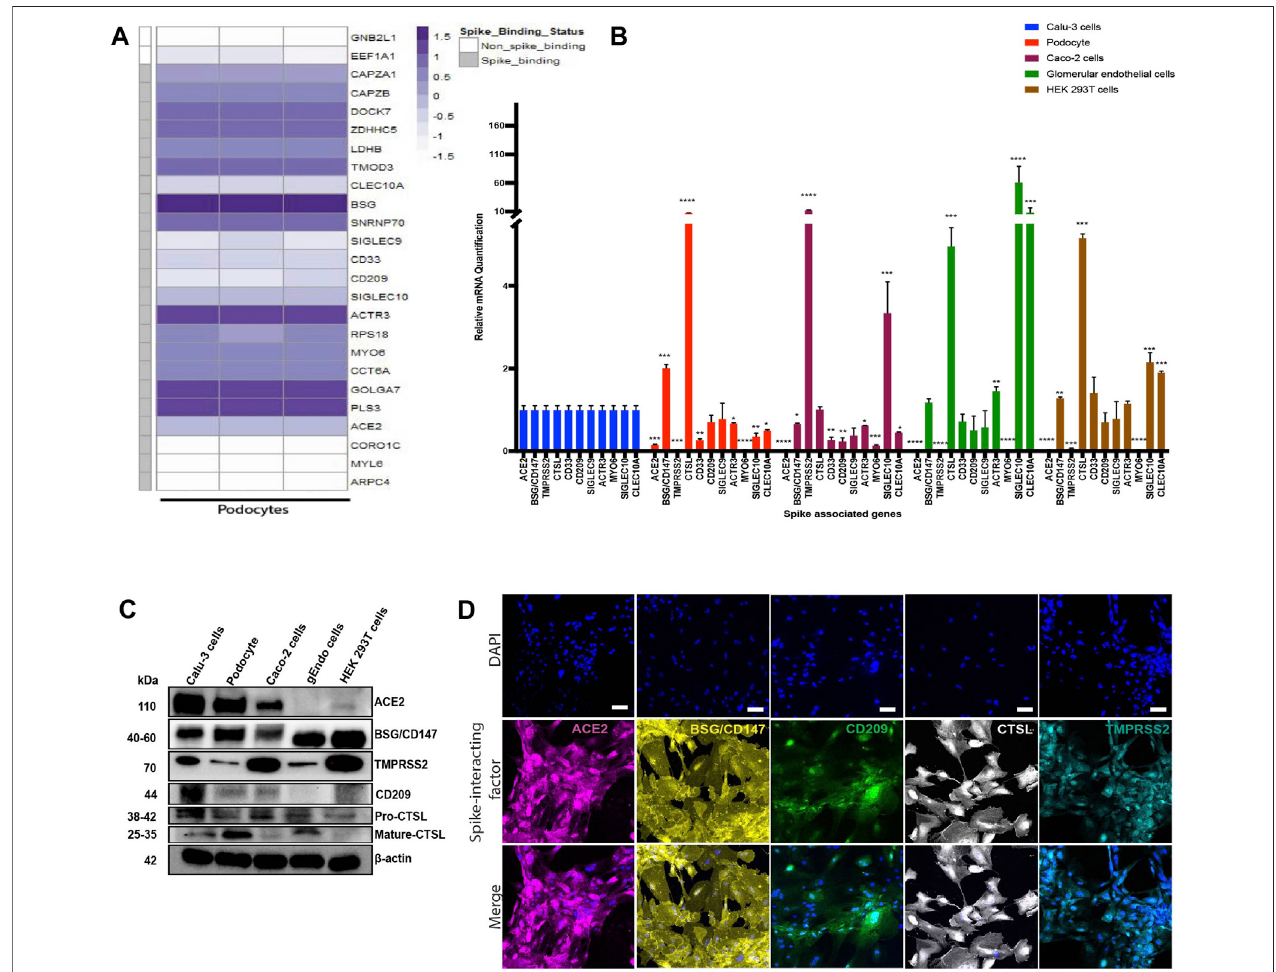
FIGURE 4 | Transcriptomic and protein level analyses of spike-interacting factors in mature podocytes differentiated from human iPS cells. (A) Heatmap showing expression levels of spike associated genes from three biological human iPS cell-derived podocyte samples. SIGLEC9, Sialic acid-binding Ig-like lectin 9; CAPZA1, F-actin-capping protein subunit alpha-1; CLEC10A, C-type lectin domain family 10 member A; CD33, Myeloid cell surface antigen CD33; TMOD3, Tropomodulin-3; ACE2, Angiotensin Converting Enzyme 2; BSG/CD147, Basigin/CD147 molecule; CD209, CD209 Antigen; MYO6, Unconventional myosin-VI; PLS3, Plastin-3; LDHB, L-lactate dehydrogenase B chain; GNB2L1/RACK, Receptor of activated protein C kinase 1; SNRNP70, U1 small nuclear ribonucleoprotein 70 kDa; DOCK7, Dedicator of cytokinesis protein 7; RPS18, 40S ribosomal protein S18; CAPZB, F-actin-capping protein subunit beta; GOLGA7, Golgin subfamily A member 7; ZDHHC5, Palmitoyltransferase ZDHHC5; SIGLEC10, Sialic acid-binding Ig-like lectin 10; ACTR3, Actin-related protein 3; MYL6, Myosin light polypeptide 6; CORO1C, Coronin-1C; ARPC4, Actin-related protein 2/3 complex subunit 4; CCT6A, T-complex protein 1 subunit zeta; (B) qPCR quanti fi cation of nine of the human spike- associated gene from (A) including Transmembrane Serine Protease 2 (TMPRSS2) or cathepsin L (CTSL) in human iPS cell-derived podocytes, Calu-3, Caco-2, glomerular endothelialcells, and HEK 293Tcells (normalized toCalu-3 groups). (C) Westernblot analysis toevaluate protein expression ofACE2, BSG/CD147,CD209, TMPRSS2 and CTSL in the different cell type used; Calu-3, human iPS cell-derived podocytes, Caco-2, glomerular endothelial (gEndos) cells, and HEK 293T cells. (D) ImmunocytochemistryanalysisofACE2, BSG/CD147, CD209,TMPRSS2and CTSL expression in iPS cell-derived podocytes. Scale bar:100 µm.One-way analysisof variance (ANOVA) with Sidak ’ s multiple comparison test was used to determine statistical signi fi cance. Only p values of 0.05 or lower were considered statistically signi fi cant ( p > 0.05 [ns, not signi fi cant], p < 0.05 [*], p < 0.01 [**], p < 0.001 [***], p < 0.0001 [****]). Error bars indicate standard deviation of the mean.